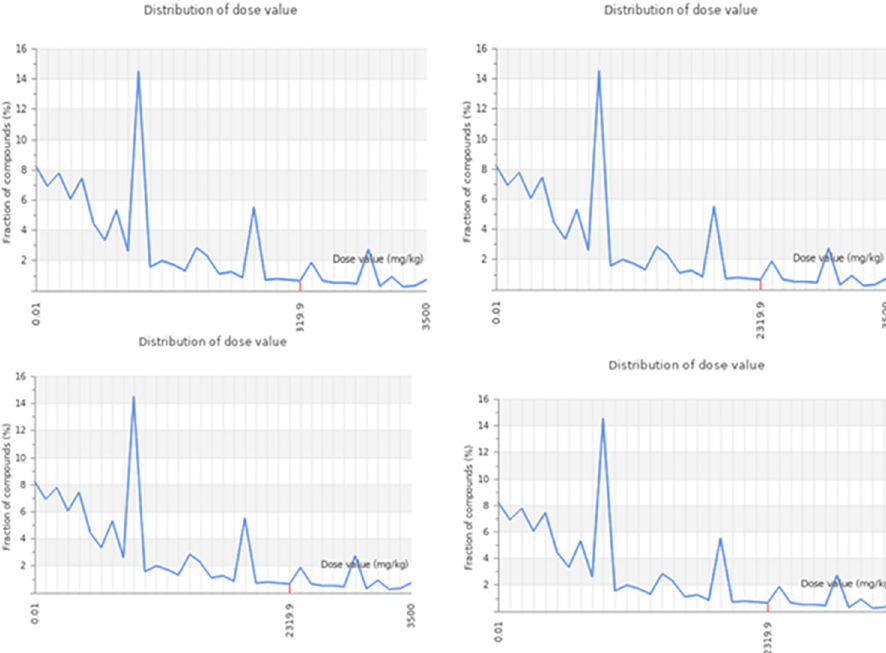
Fig 7. Graphical representation of predicted dose value distribution for Acyl-[acyl-carrier-protein]—UDP-N acetyl glucosamine O-acyltransferase protein. In this graph, x-axis represents distribution of dose value and y-axis represents fraction of compounds.